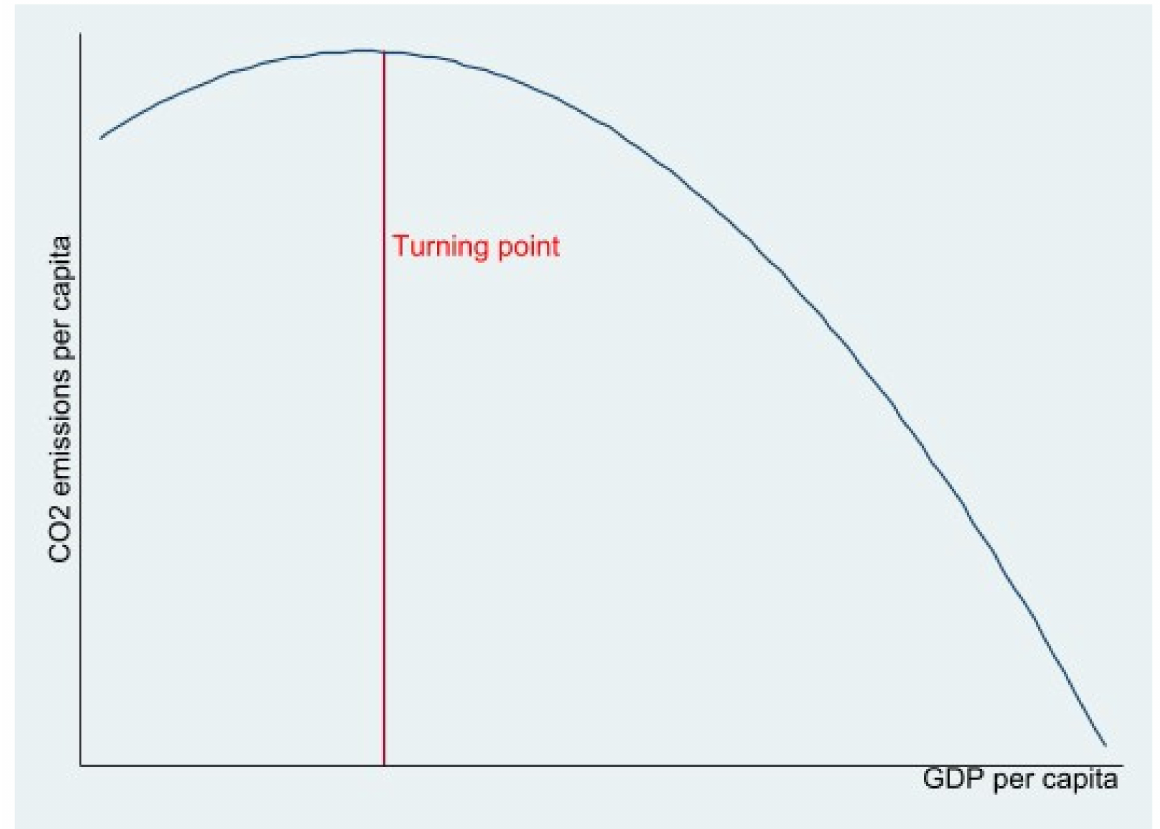
Figure 2. The Environmental Kuznets Curve turning